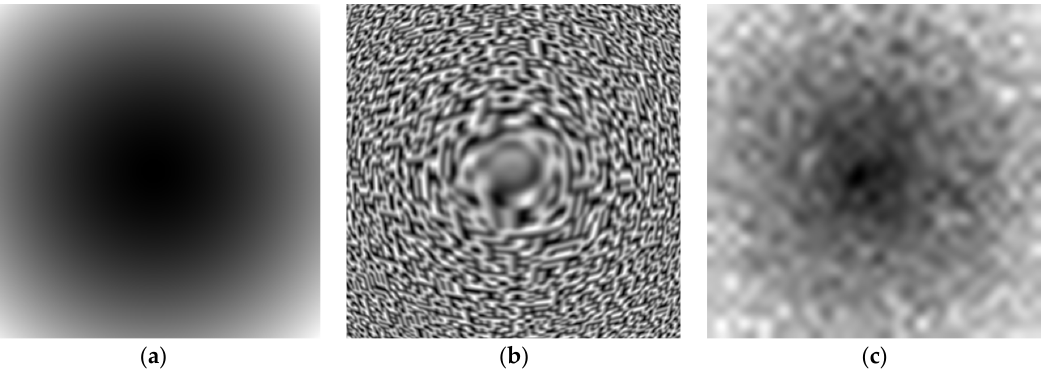
Figure 11. Demonstration of zoom factor reconstruction based on Perlin noise. ( a ) Frequency diagram etalon. ( b ) Perlin noise. ( c ) Restored frequency diagram.